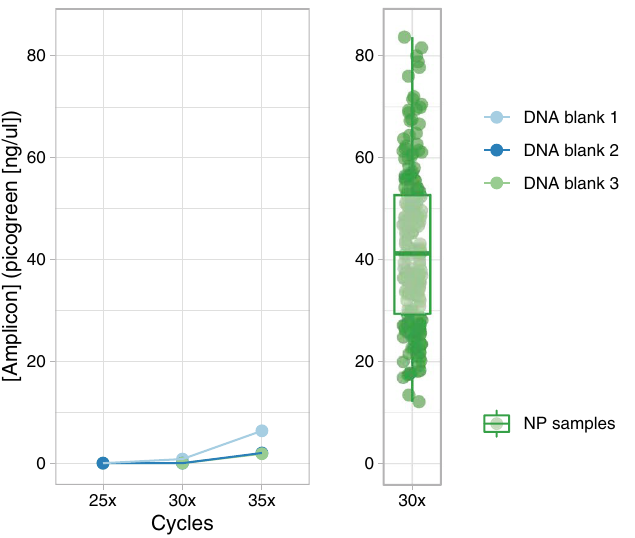
Figure 3. DNA concentration of 3 DNA blanks and 214 NP samples after PCR amplification. DNA concentration was estimated by picogreen quantification. The concentration of DNA blanks is visualized in the left graph shown for 25, 30 and 35 amplification cycles. The DNA concentration of the NP samples amplified by 30 PCR cycles are shown in the boxplot. NP samples had a median concentration of 41.3 ng/µl (range: 12.1–83.7). Boxplot depicts the 25th and 75th percentiles by lower and upper hinges, respectively, the median is depicted by a horizontal line in the box. The measurements that fall within 1.5 times the interquartile range are shown by whiskers. Each green dot is an individual NP